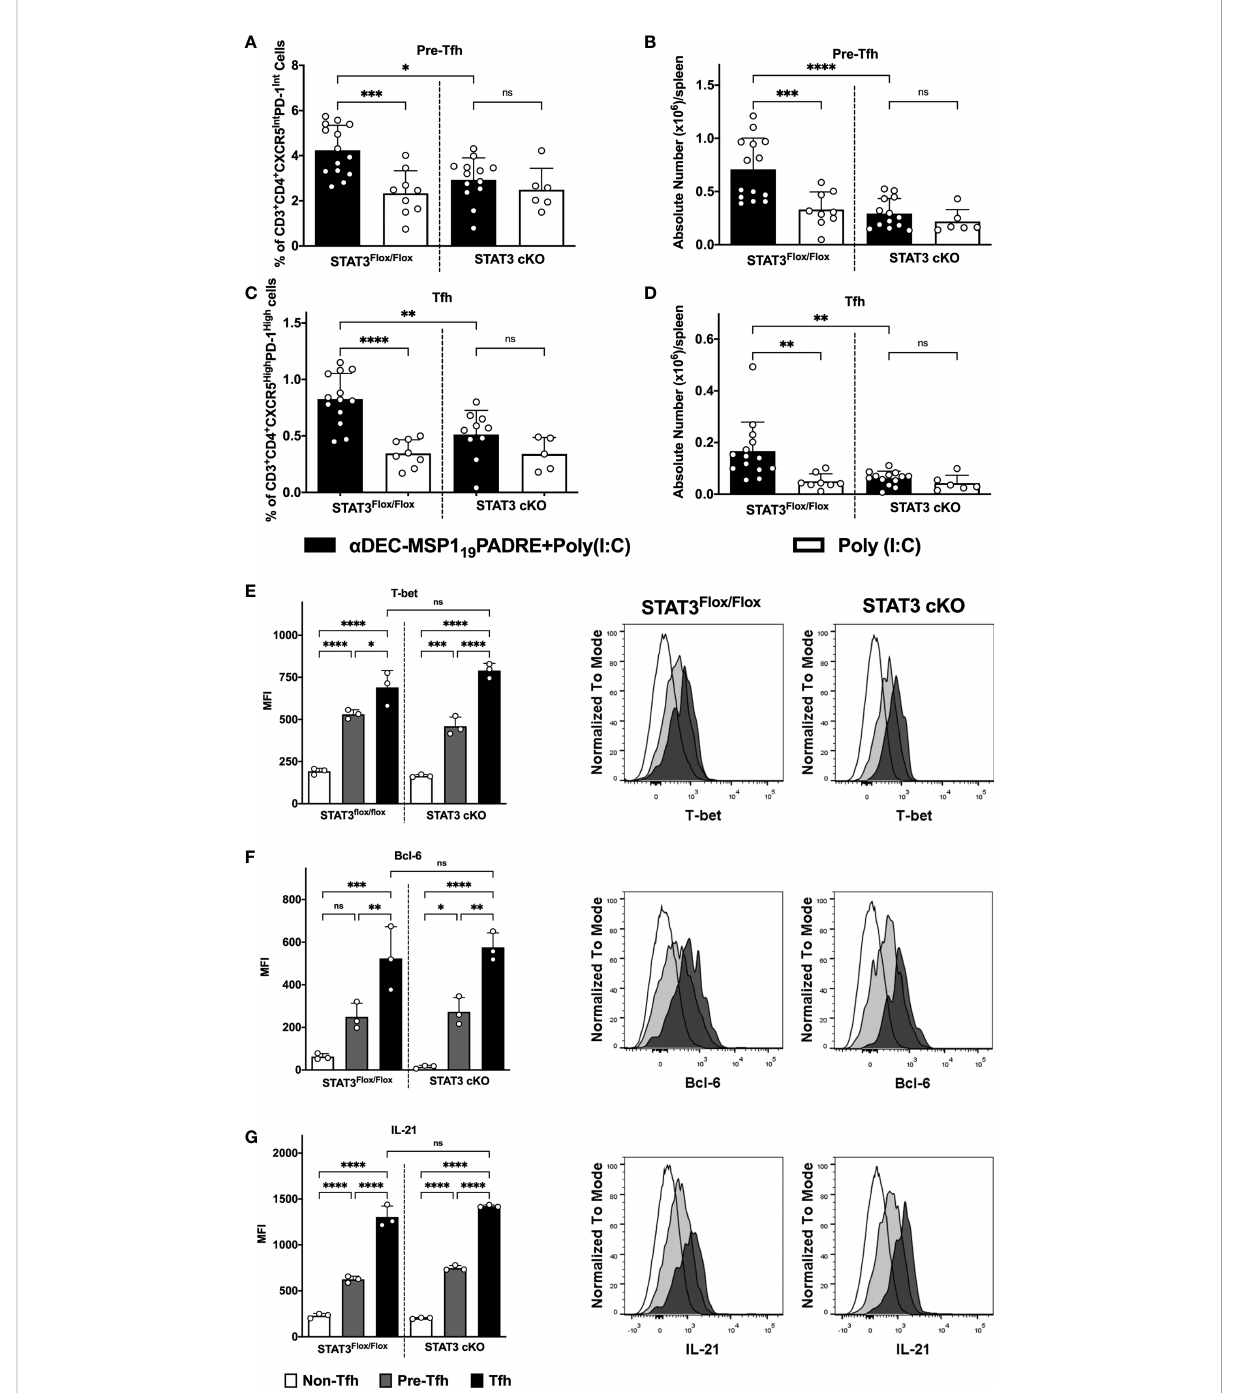
FIGURE 4 STAT3 signaling controls cDC1 ability to prime Tfh cells after antigen targeting to the DEC205 receptor. STAT3 Flox/Flox and STAT3 cKO mice were immunized as described in Figure 3. Splenocytes were obtained 4 days after boosting and Tfh cells were analyzed by fl ow cytometry. (A) Frequency and (B) absolute number of pre-Tfh cells (CD3 + CD4 + CXCR5 Inter PD-1 Inter ) in the spleen. (C) Frequency (D) and absolute number of Tfh cells (CD3 + CD4 + CXCR5 High PD-1 High ) in the spleen. Intracellular staining of Bcl-6 (E) , T-bet (F) , and IL-21 (G) in Tfh, pre-Tfh and non-Tfh cells (CD3 + CD4 + CXCR5 - PD-1 - ) cells performed by fl ow cytometry in splenocytes 4 days after immunization. Histograms represent Non-Tfh cells in white, Pre-Tfh cells in gray and Tfh cells in black. Bars show mean ± SD from six experiments pooled together (n=5-14 animals/group) in (A-D) and one representative result out of 3 independent experiments (n=3 animals/group) in (E – G) . *p<0.05, **p<0.01, ***p<0.001, ****p<0.0001, and ns not signi fi cant; one-way ANOVA followed by Tukey ’ s